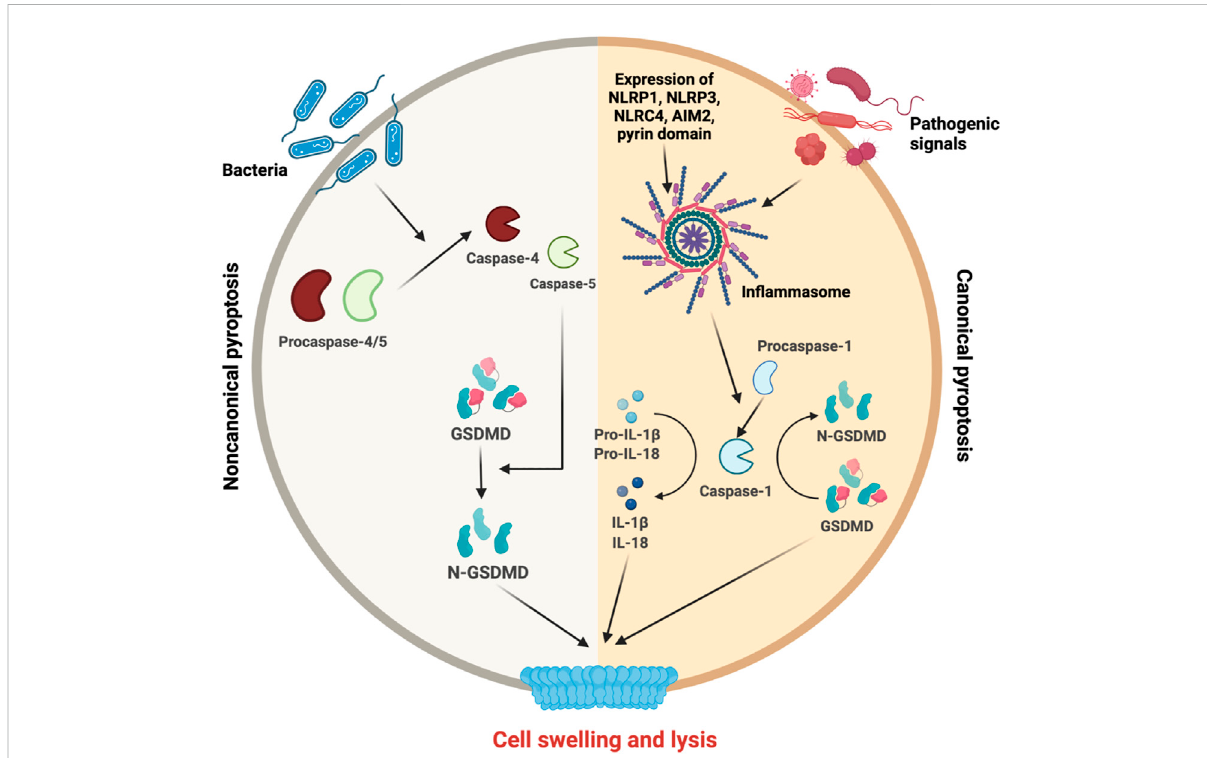
FIGURE 4 Molecular mechanismsof pyroptosis. Upon theinitiationof noncanonical pyroptosis or canonicalpyroptosis,differentin fl ammatory actors are triggered.Ontheleftside,pro-caspase4/5 arecleaved fortheir maturationandparticipate innoncanocical pathway tocleave GSDMD intoitsactive form N-GSDMD. On the right side, canonical pathway requires in fl ammasome formation to activate the caspase-1. The caspase-1 is necessary for GSDMD cleavage and IL-1 β and IL-18 maturation, release and fi nal steps of cell swelling and